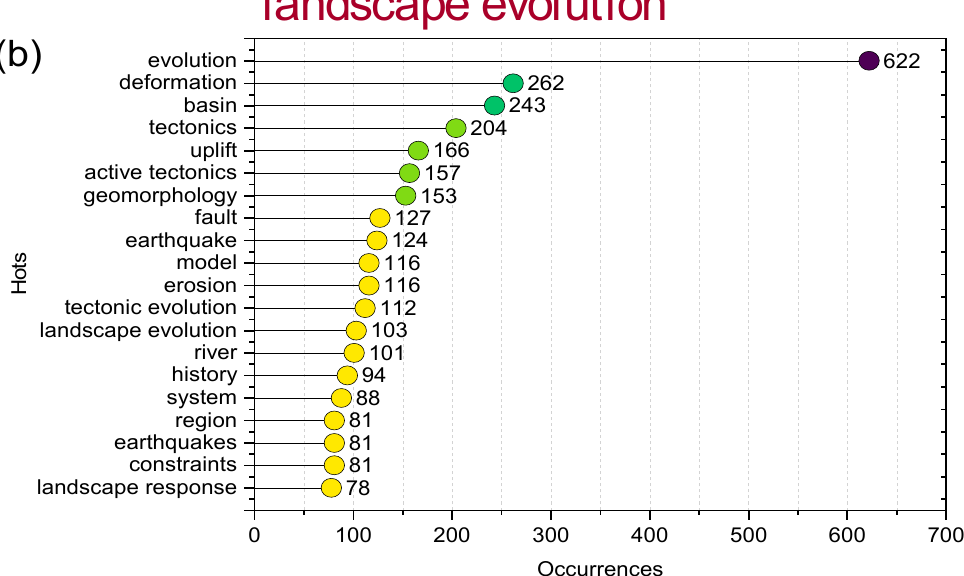
Figure 2. Top 20 main research areas in Web of Science on tectonic geomorphology research from 1981 to 2021. ( a ) the main research areas on tectonic geomorphology research, ( b ) the occurrences of top 20 research areas on tectonic geomorphology research.